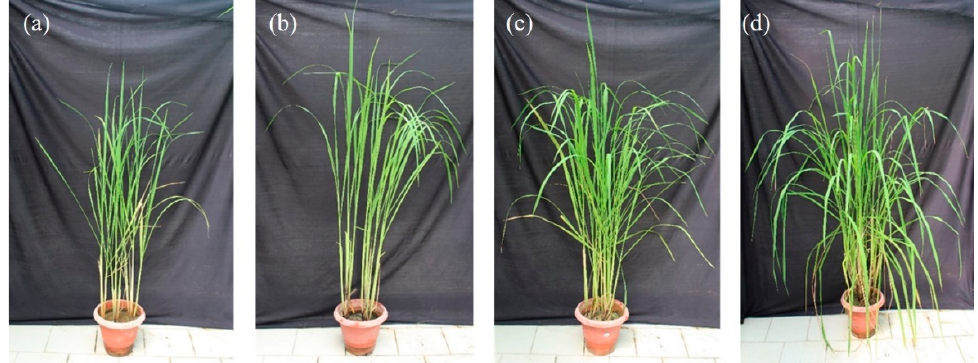
Figure 2. Pot culture experiment of black rice ( Oryza sativa L.) showing ( a ) control, ( b ) only AgNPs-treated, ( c ) only P. indica -treated, and ( d ) NEF (Nano-Embedded Fungus).